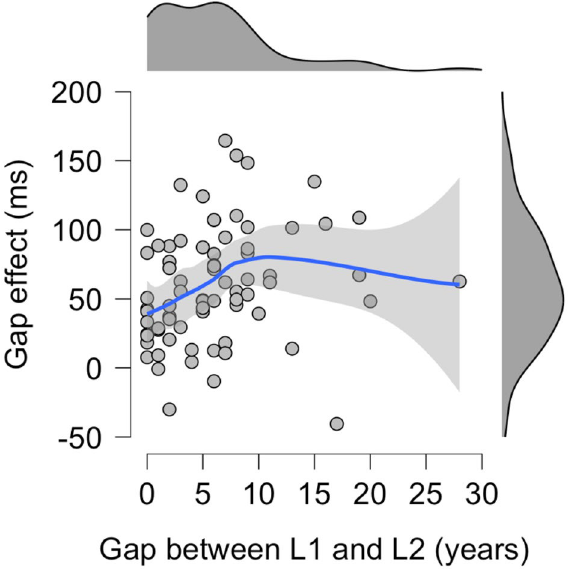
Figure 1. The gap effect was smaller in early bilinguals than late bilinguals. This suggests that early bilinguals disengage attention faster than late bilinguals. Bilingual experience was calculated by subtracting age of L1 acquisition from age of L2 acquisition (in years); data close to zero represent bilinguals who acquired their L2 shortly after their L1 (‘early bilinguals’), data far from zero represent bilinguals who acquired their L2 later in life (‘late bilinguals’). The grey shaded area represents 95% confidence